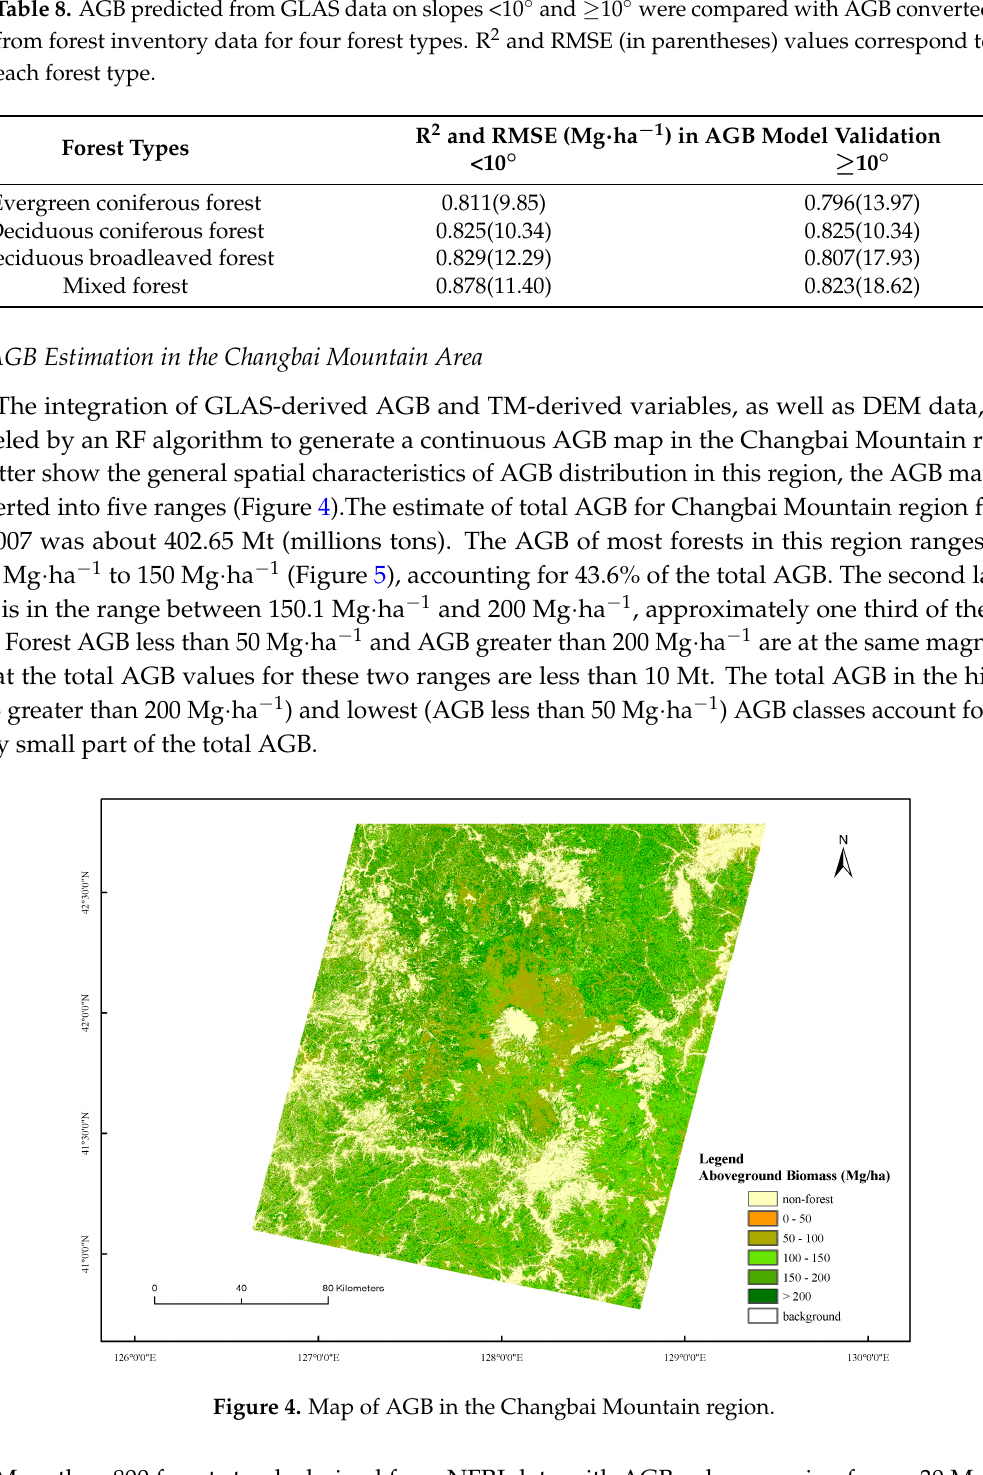
Figure 5. Distribution of forest AGB from AGB predicted map in five classes.